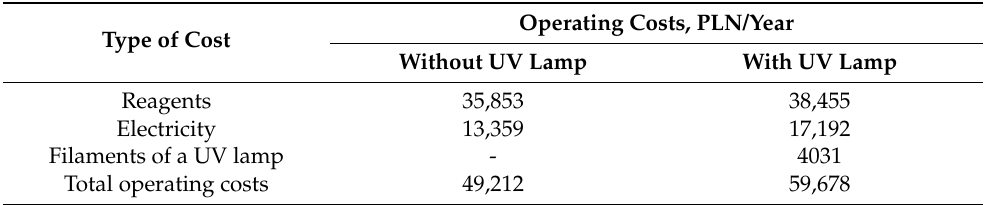
Table 2. The operating costs of the water treatment system without and with the low-pressure UV lamp (PLN 1 = EUR ~0.22).